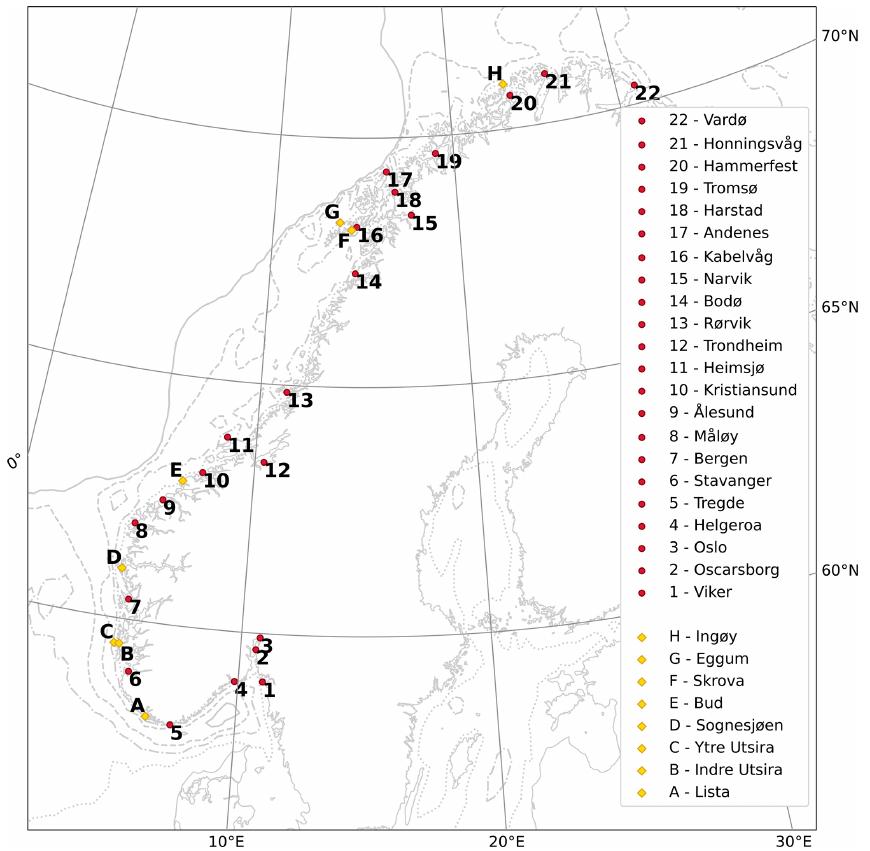
Figure 1. Location of the tide gauges and of the hydrographic stations considered in this study (red circles and yellow diamonds, respectively). The solid, dashed, dash-dotted, and dotted light gray lines indicate the 500, 300, 150, and 50m isobaths,